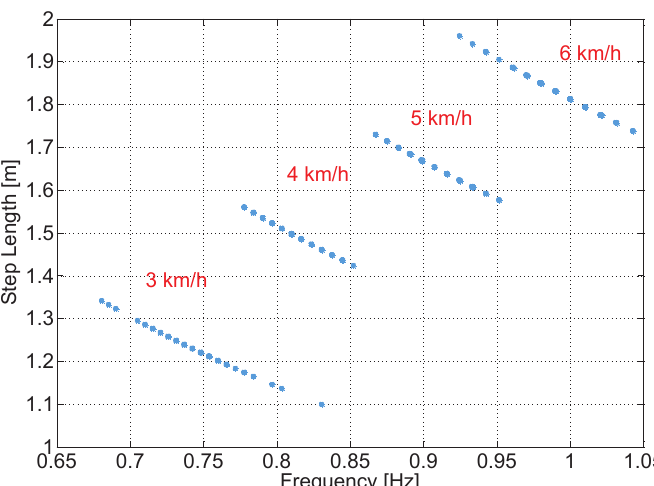
Figure 11. The points represent the steps from data gathered for one volunteer and each cloud of points represents a different speed.